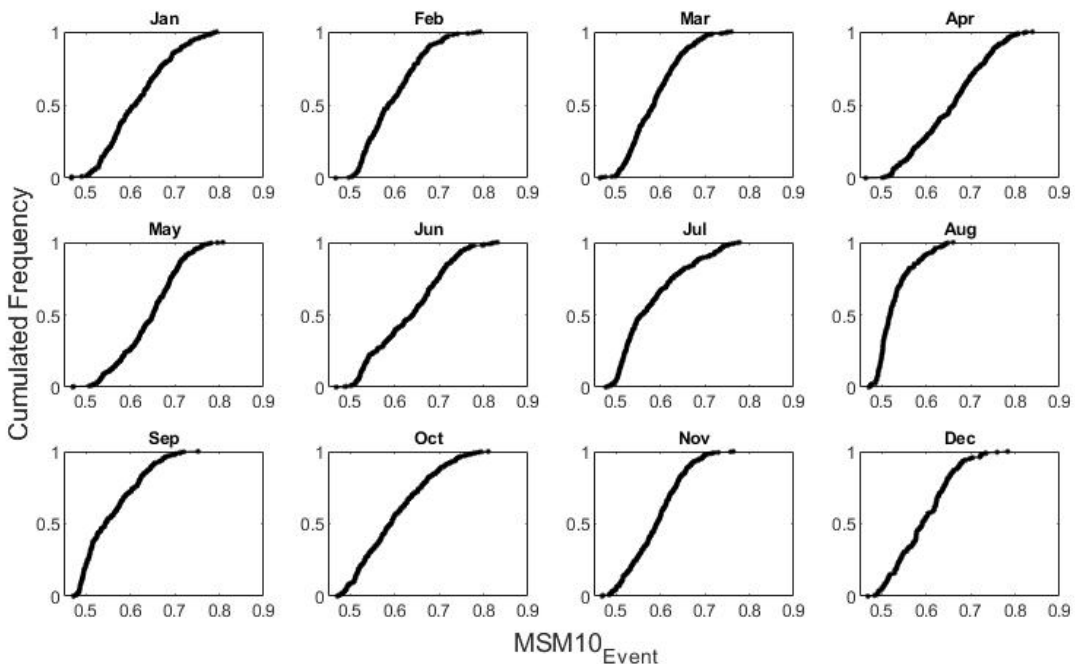
Figure 6. Cumulated frequency distributions of MSM10Event values within the 50 years of simulation for each month of the year.